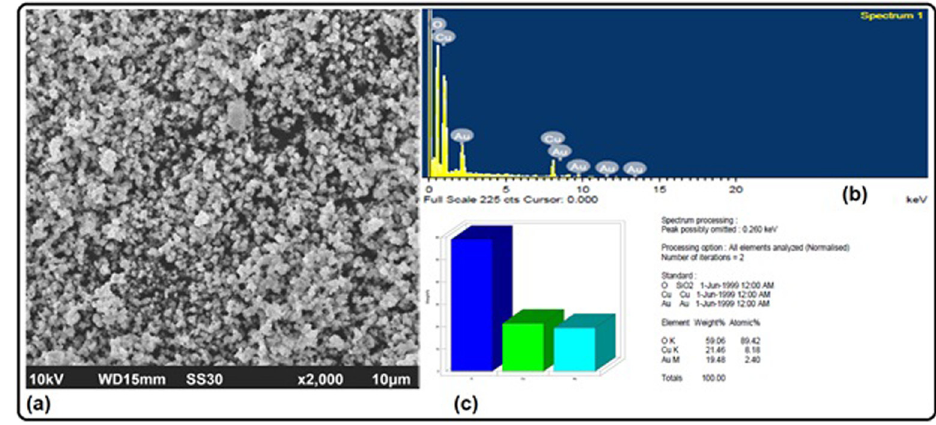
Figure 4: ( a ) SEM image and ( b ) EDX pro fi le of the biogenic CuO NPs. ( c ) a bar chart depicting the weight % of CuO NPs.